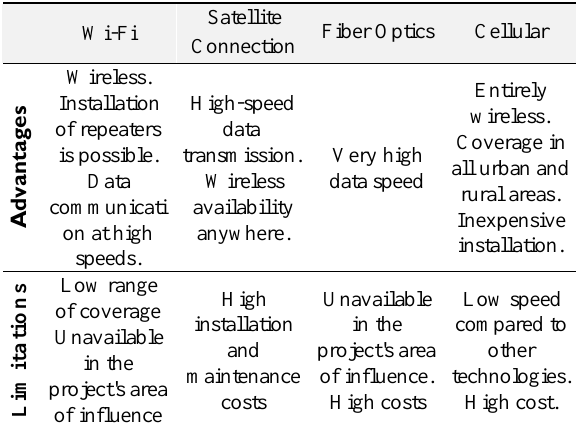
Table 2. Internet connection